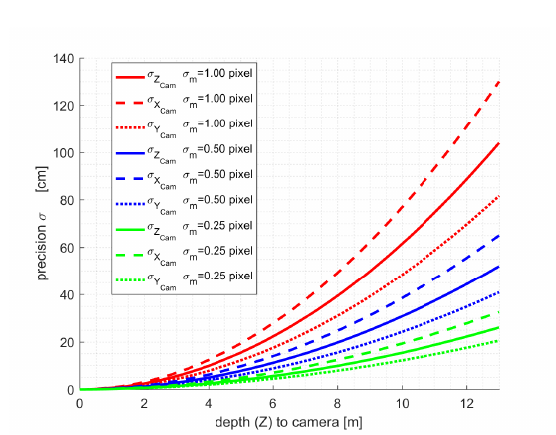
Figure 5. Standard deviations in 3D space at the image border in Figure 7. Precision with the BC and the WC error model for 0 ◦ , 10 ◦ , 45 ◦ , 65 ◦ and 90 ◦ pitch angle and 0.25pixel matching the camera coordinate system.